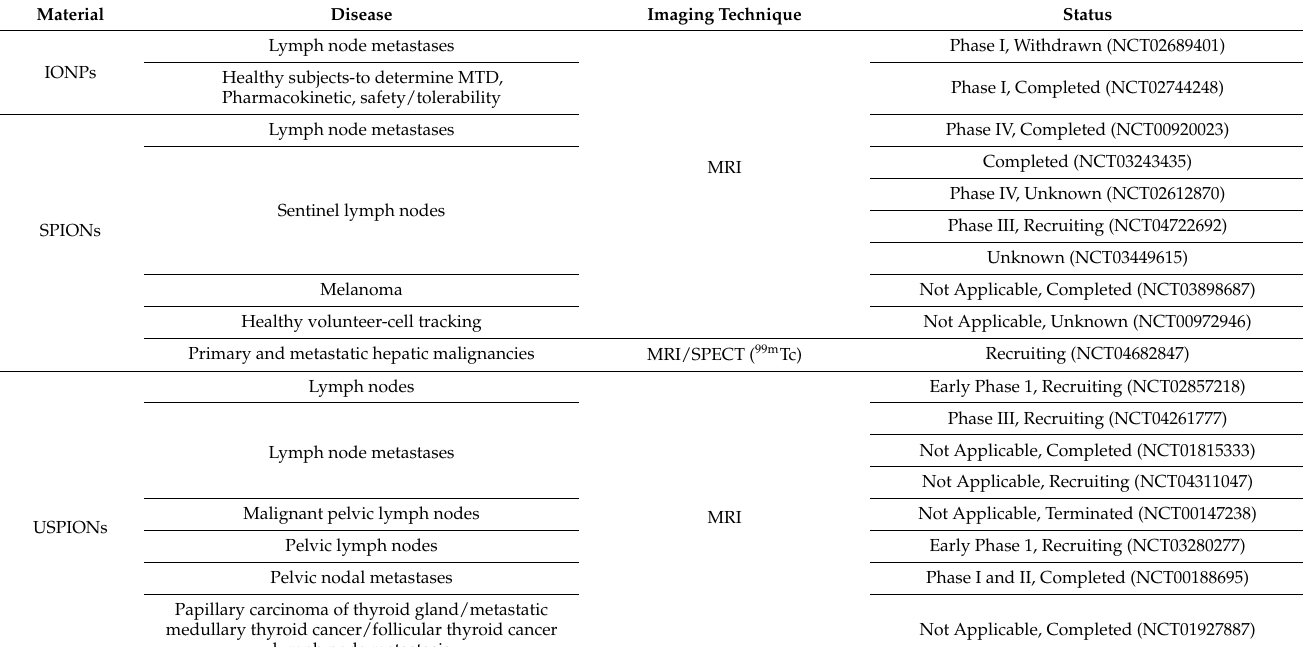
Table 7. Iron oxide-based nanoparticles currently under evaluation for human use in imaging (up to 10 March 2021) [277].